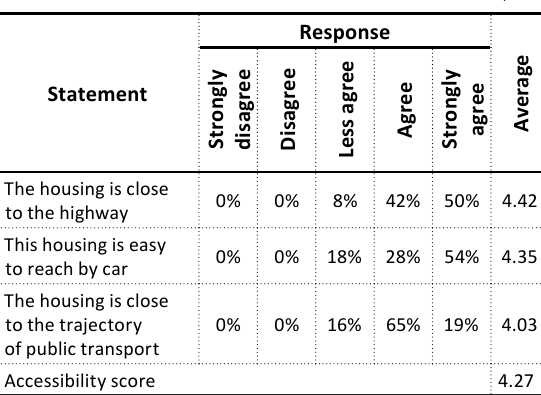
Table 3. Accessibility construct descriptive